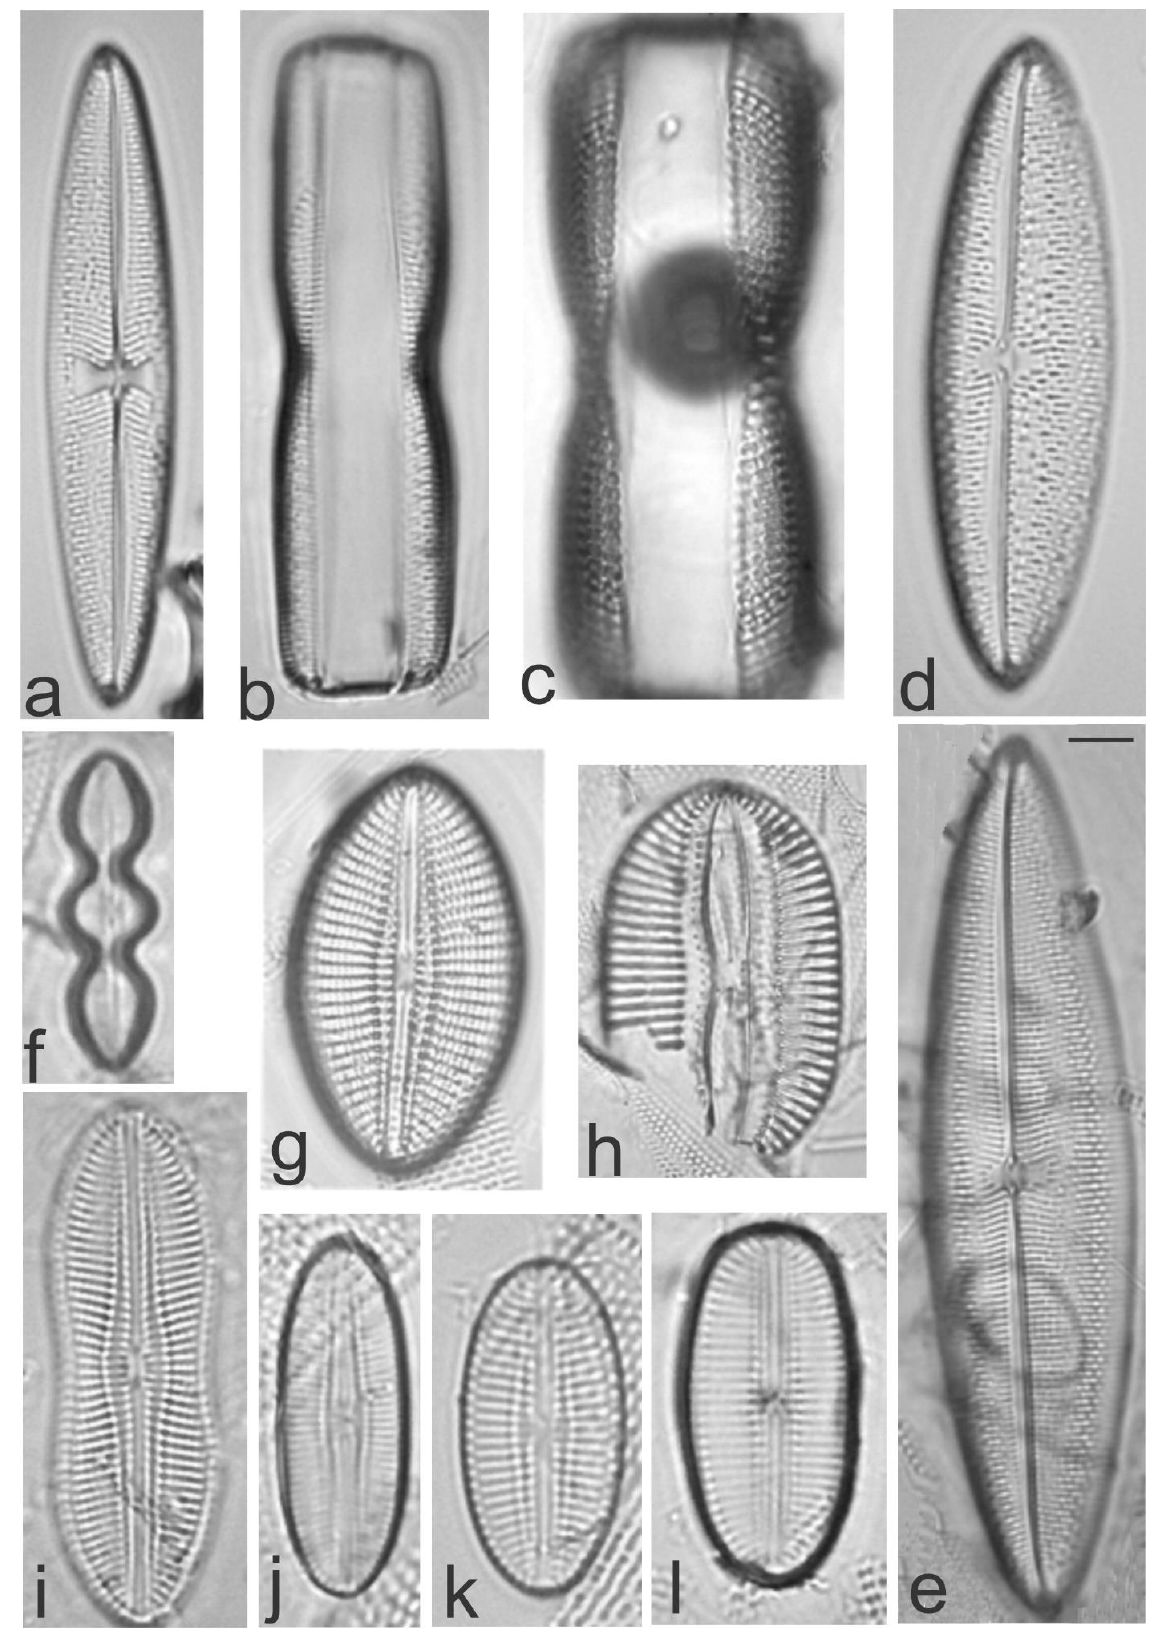
Figure 22. ( a , b ) Trachyneis aspera ; ( c – e ) T. velata ; ( f ) Caloneis egena ; ( g ) Diploneis smithii ; ( h ) D. suborbicularis ; ( i ) D. vacillans var. renitens ; ( j ) D. vacillans var. vacillans ; ( k ) Diploneis parca ; ( l ) D. litoralis var. clathrata . Scale bar = 5 μm.